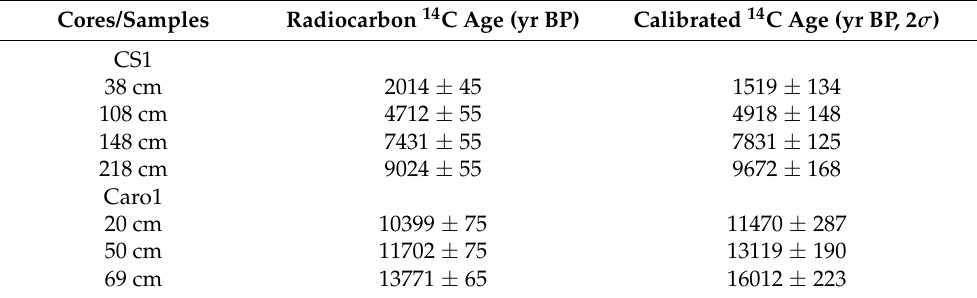
Table 1. Radiocarbon data available for cores CS1 and